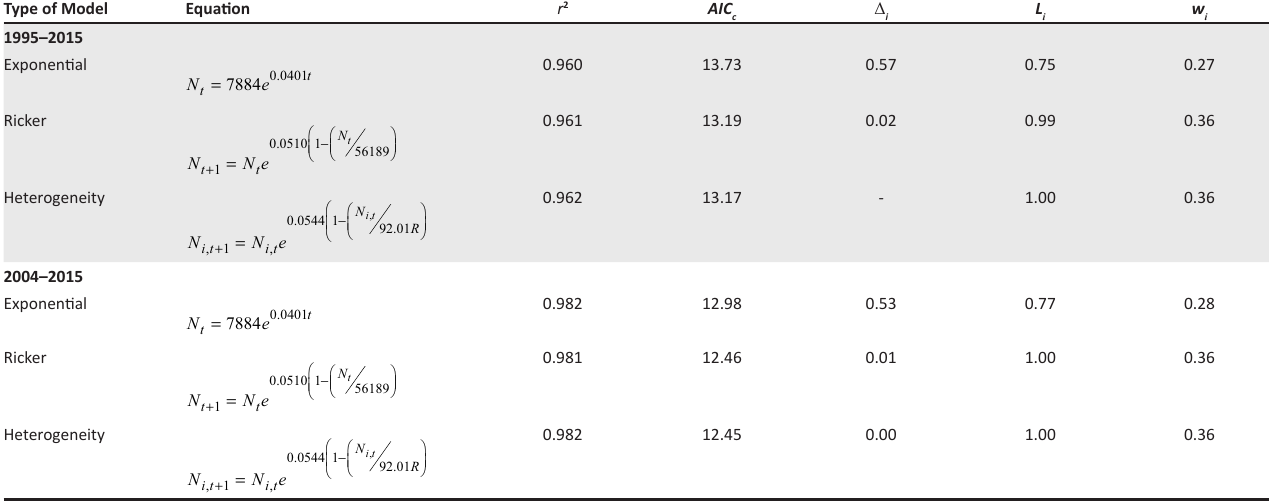
TABLE 1: Population model comparisons made for minimum number of elephants living in the Kruger National Park since 1995. Type of Model